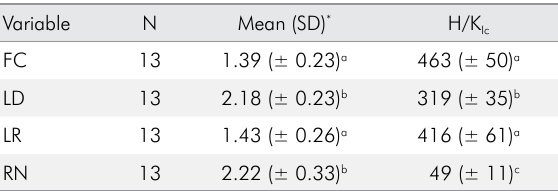
Table 4. Means and standard deviation (SD) for K across the materials tested. The third column presents the average by Vickers hardness (H) presented in table 2 and K ). (H/ K Ic